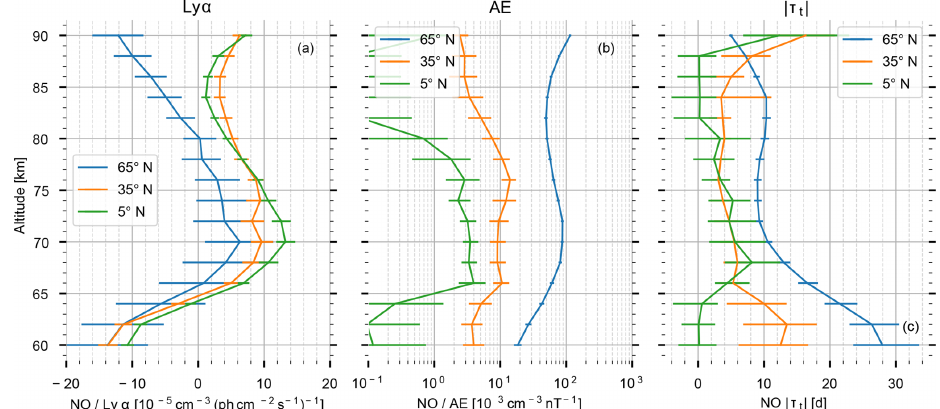
Figure 5. Coefficient profiles of the solar index parameter (Lyman- α , left, a ), the geomagnetic index parameter (AE, middle, b ), and the amplitude of the annual variation of the NO lifetime (right, c ) at 5 (green), 35 (orange), and 65 ◦ N (blue). The solid line indicates the median, and the error bars indicate the 95% confidence region.